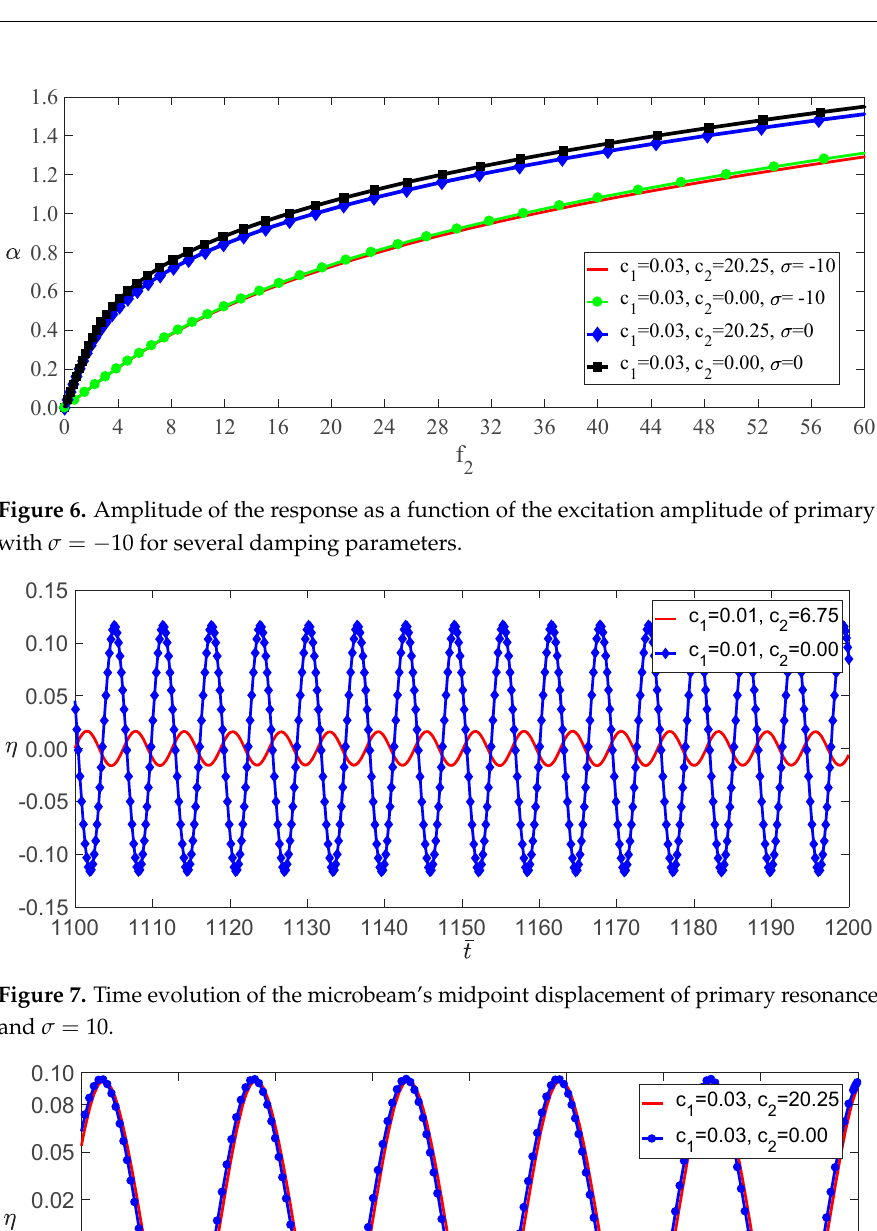
Figure 5. Frequency-response curves of primary resonance for =